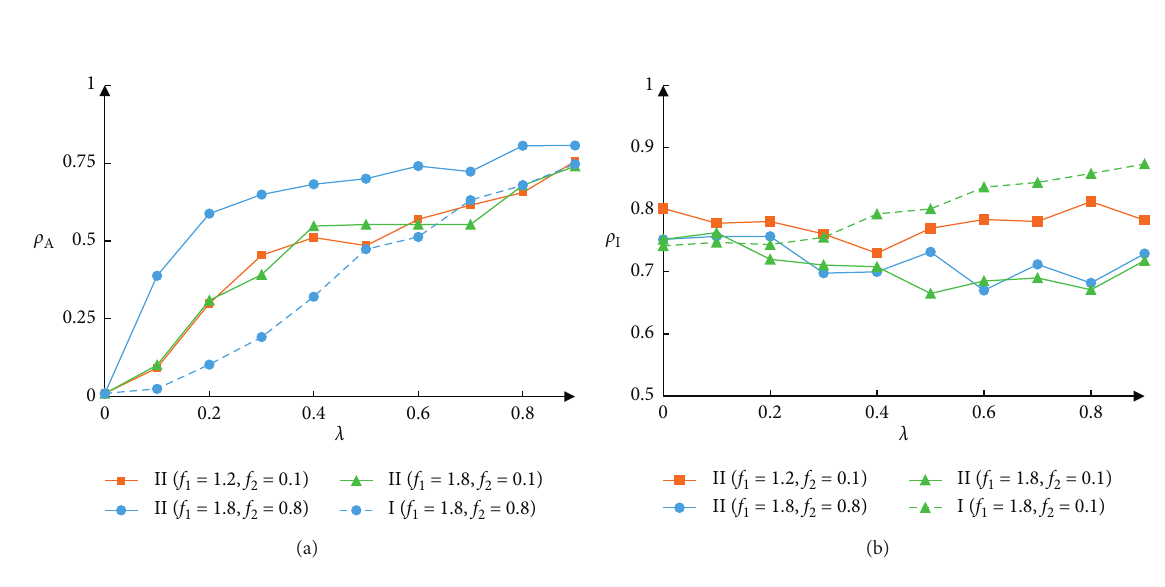
Figure 12: The influence of β on ρ